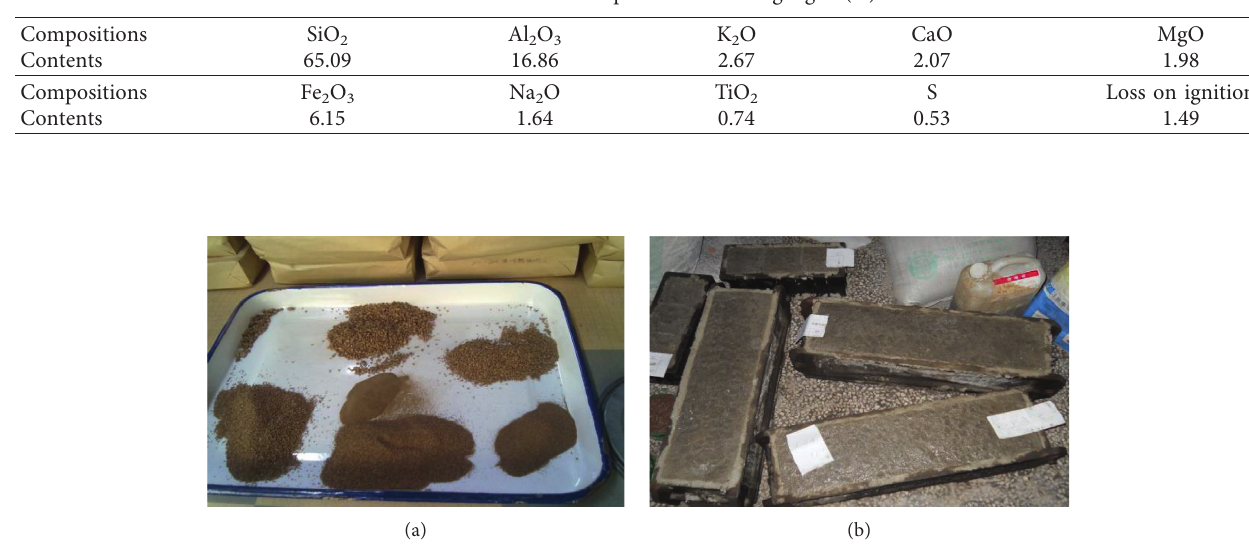
Table 1: Chemical compositions of coal gangue